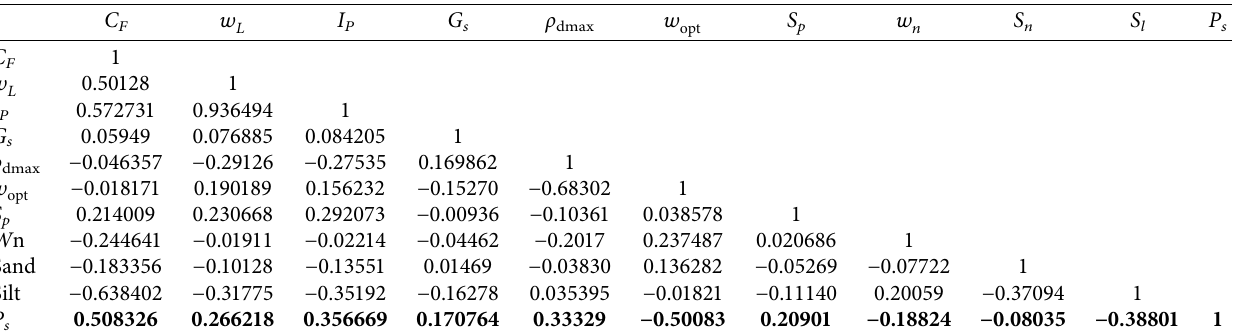
Table 3: Pearson correlation matrix for the inputs and output